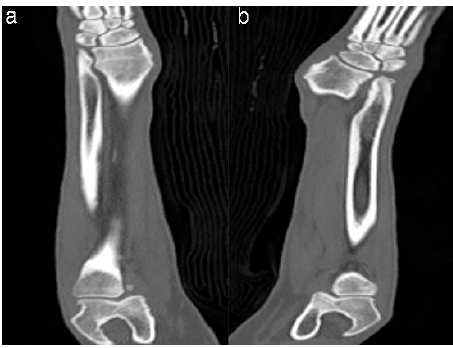
Figure 2. CT from the distal third of the humerus to the metacarpal bones of both the affected ( a ) and unaffected leg ( b ).